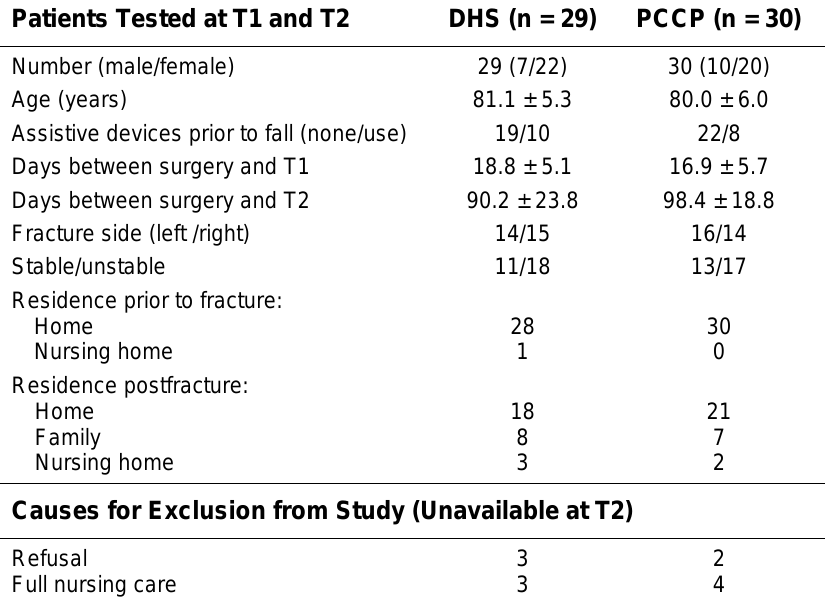
Characteristics of Included Patients Examined at T1 and T2, and Causes for Unavailability at T2 Leading to Exclusion from Study Patients Tested at T1 and